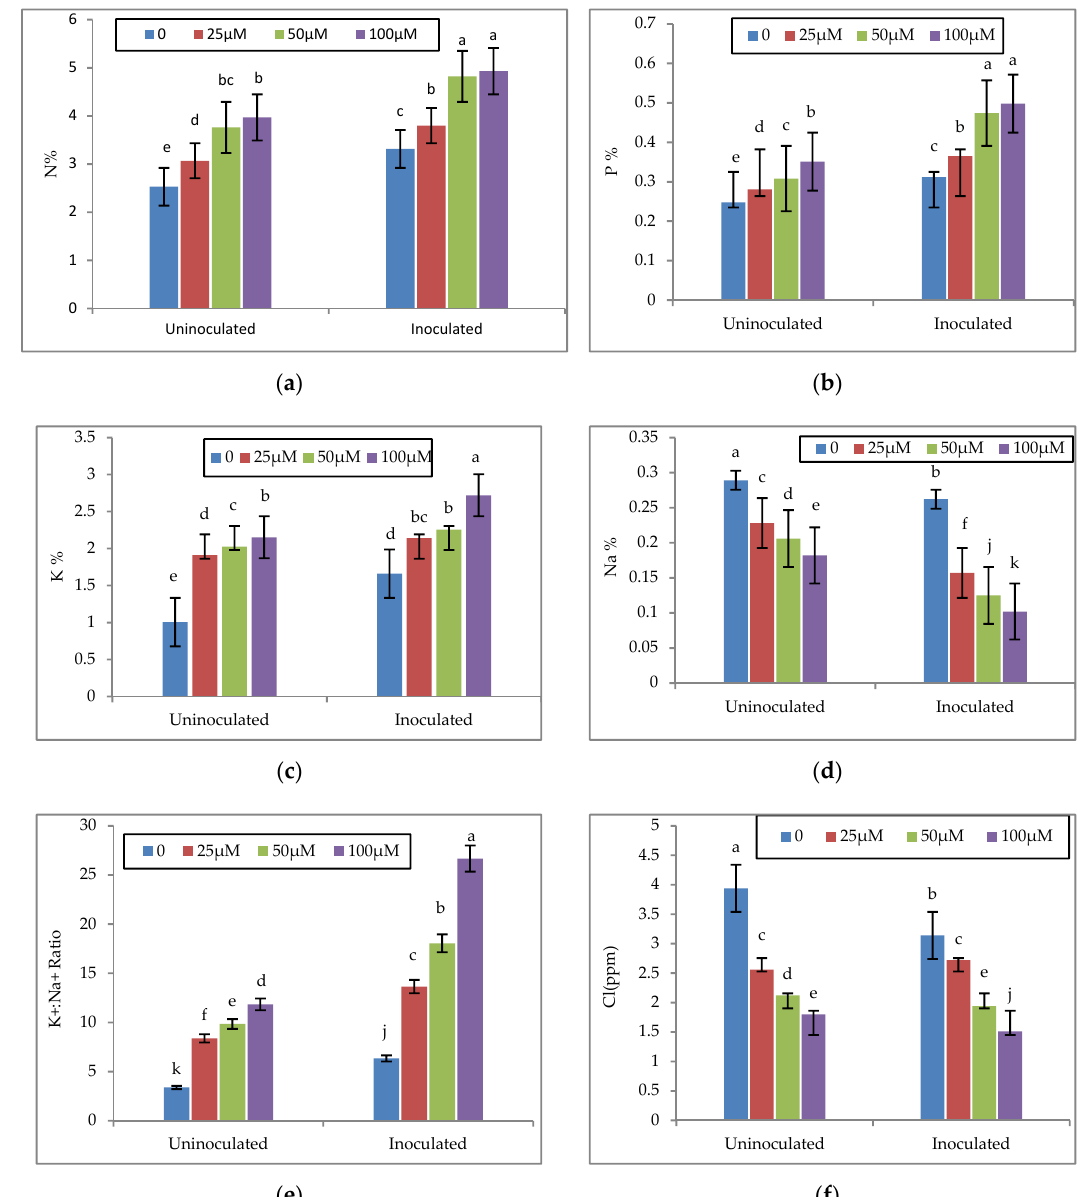
Figure 1. Effect of EPS-producing bacteria and melatonin on nutrient concentrations [N% ( a ), P% ( b ), K% ( c ), Na% ( d ) and Cl ppm ( f )] and the K + /Na + ratio ( e ) of faba bean grown in location one (saline soil). The bars of treatment followed by the same letter were not statistically different at p ≤ 0.05, according to the least significance difference (0, 25, 50, and 100 µM concentrations of melatonin).